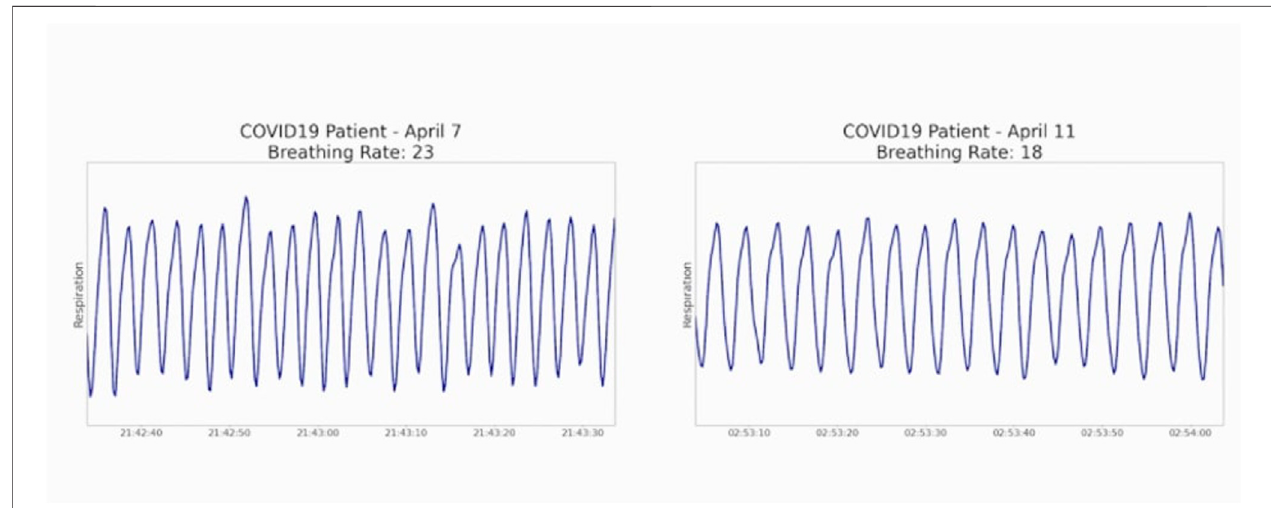
FIGURE 13 | Radar measurement of COVID-19 affected breathing. A dataset of COVID-19 patient breathing recorded by MIT ’ s product clearly illustrates the feasibility of remote respiration sensing using radar to fi ght against COVID-19. From Adam (2020).